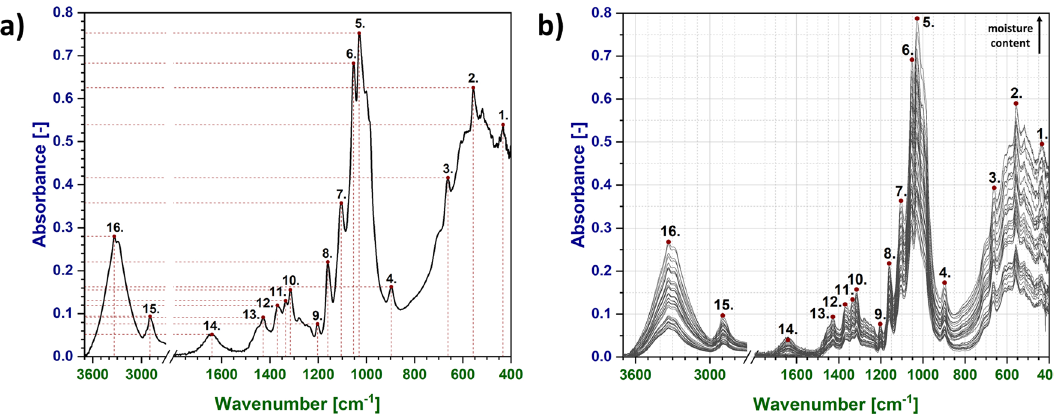
Figure 1. Exemplary ATR FT-IR spectrum of cellulose with the assignment of the peaks analysed ( a ) and visualization of the changes witnessed in the IR spectra with the elevating moisture content ( b ). Throughout the whole manuscript absorbance values are marked with dark blue and wavenumber values with dark